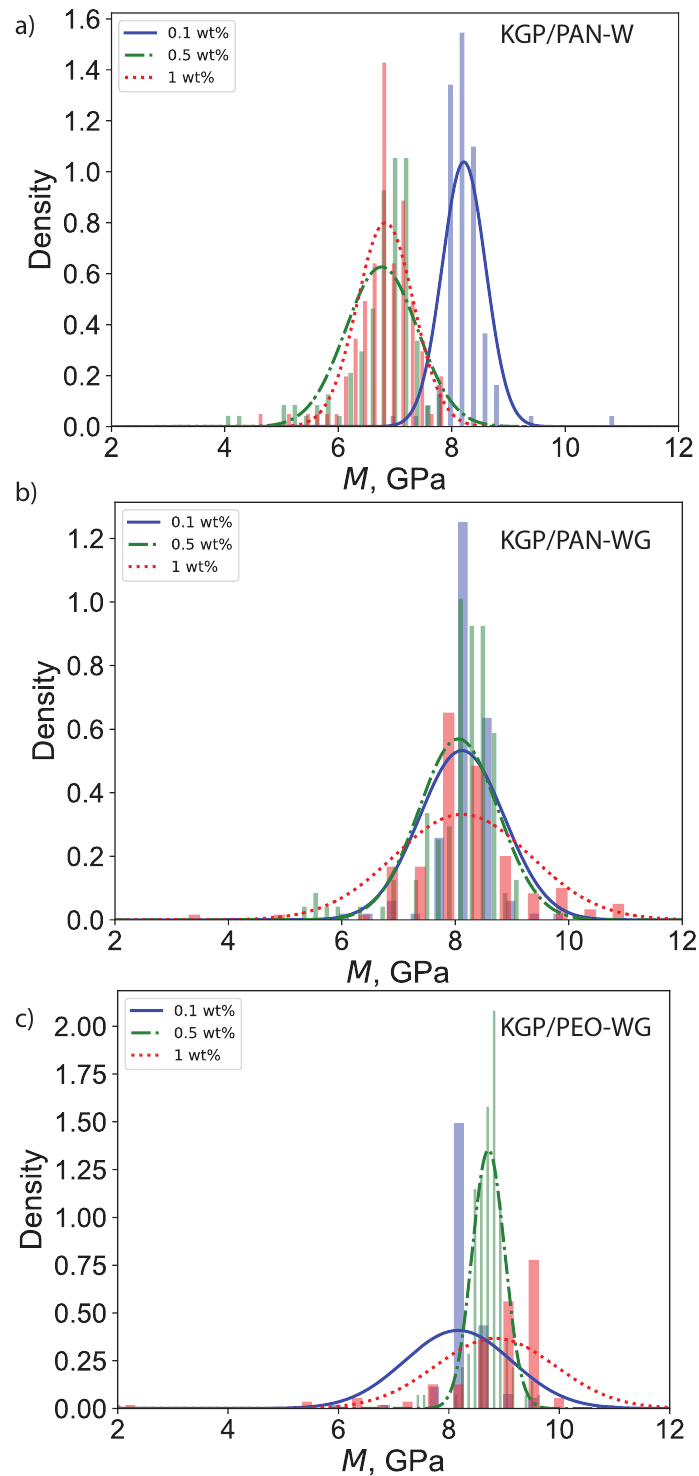
Figure 11. Histogram of indentation modulus M : ( a ) KGP/PAN-W. ( b ) KGP/PAN-WG. ( c )